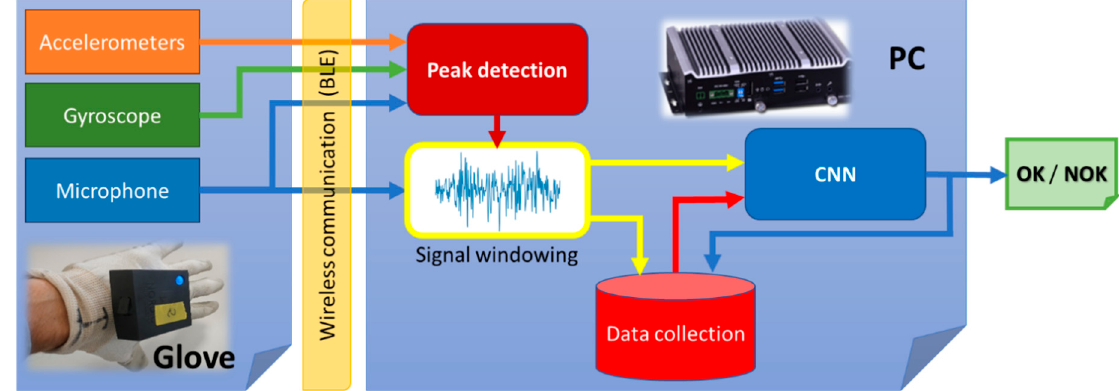
Figure 7. System architecture: the glove, which includes the accelerometers, gyroscope and microphone ( left ), the Bluetooth Low-Energy wireless communication interface ( middle ) and the personal computer (PC), which includes the peak detection subsystem, the windowing subsystem, the data collection database and the convolutional neural network ( right ).